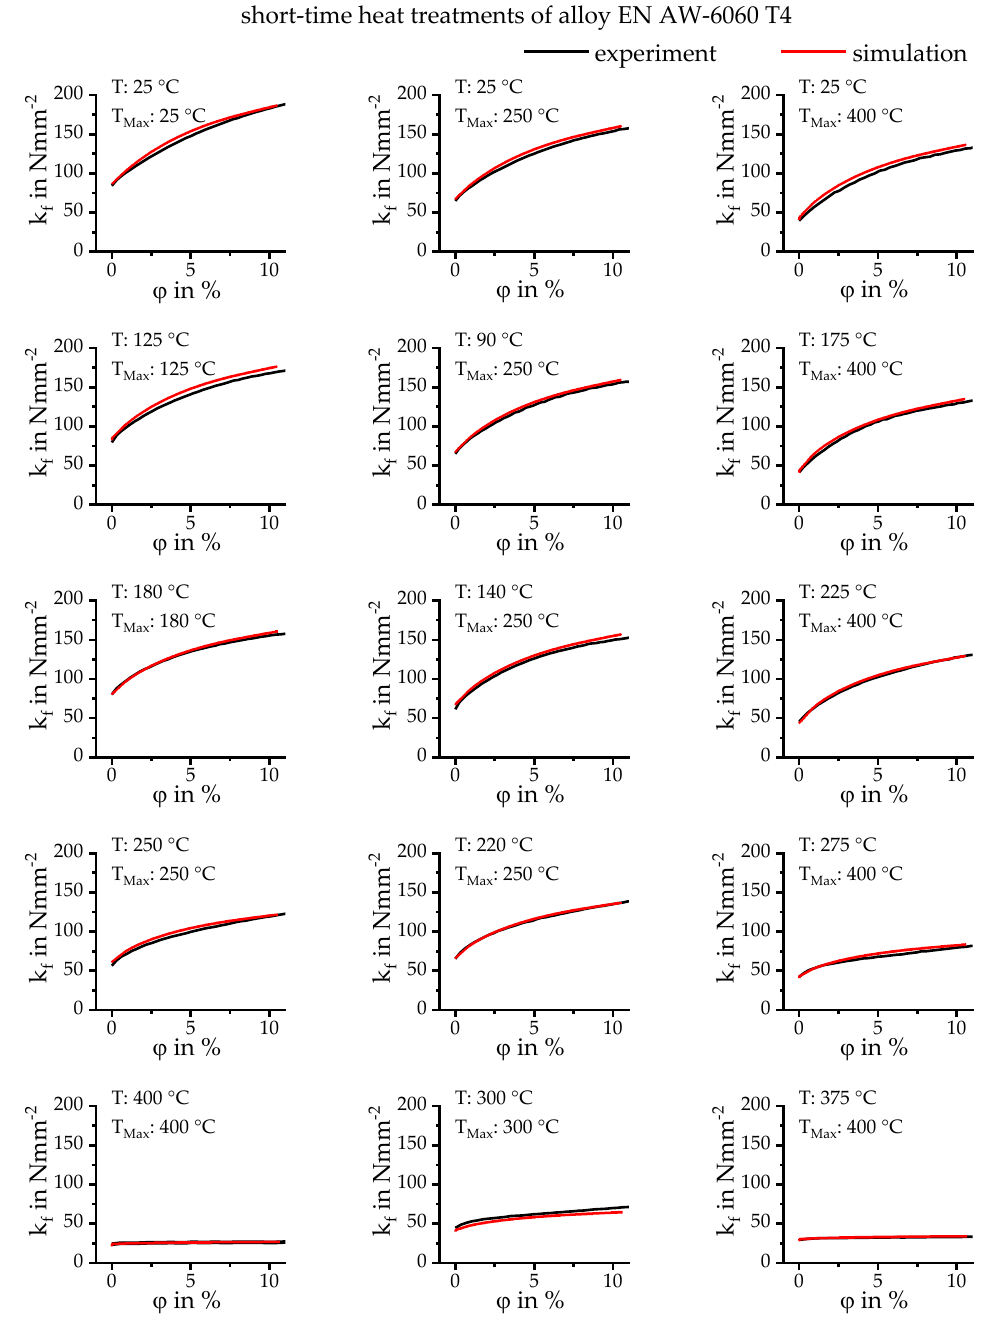
Figure19. MeasuredandsimulatedflowcurvesofalloyENAW-6060T4duringdi ff Figure 19. Measured and simulated flow curves of alloy EN AW-6060 T4 during different heat treatments.